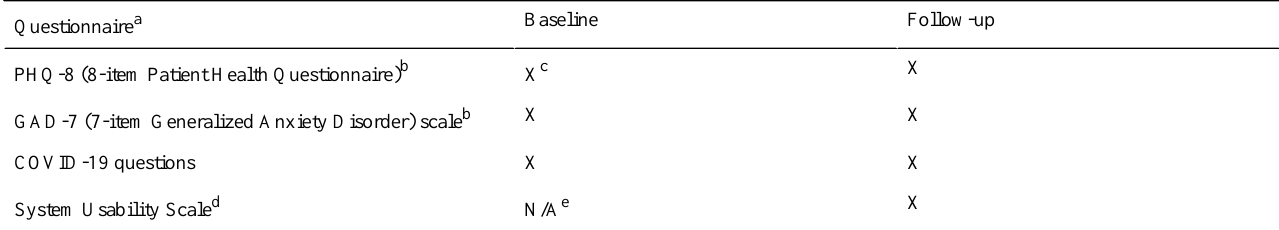
Table 1. Questionnaires included in the StayWell at Home study and timing of administration. Follow-upBaselineQuestionnaire a